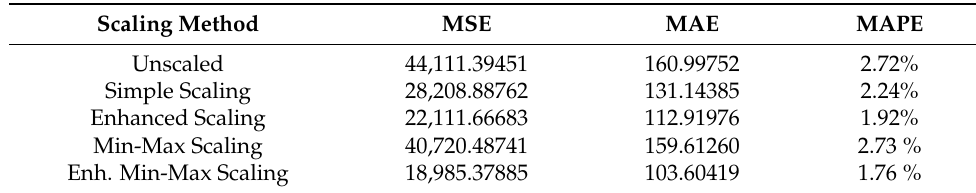
Table 5. MSE, MAE and MAPE values for the hourly load forecast. The metrics for each scaling approach investigated are